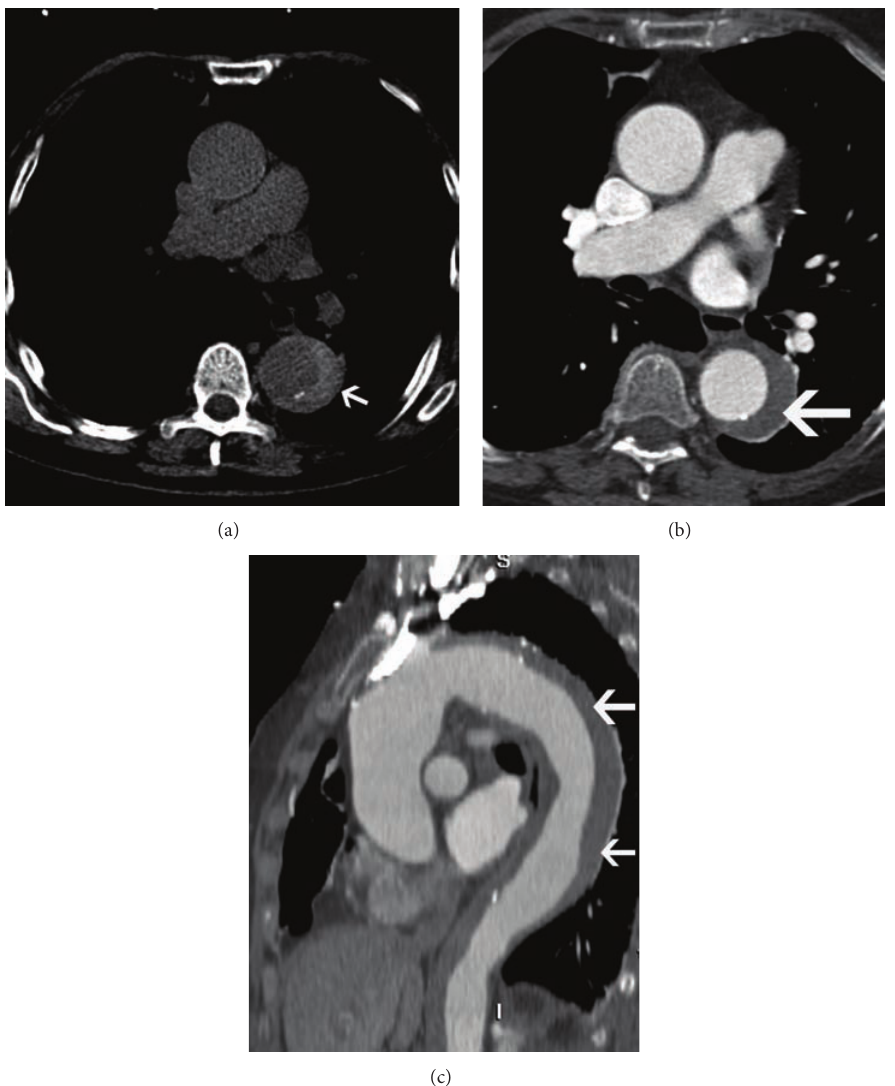
Figure 14: Intramural hematoma—(a) noncontrast axial CT scan of a 67-year-old male with acute chest pain shows a high density collection (arrow) in the periphery of the descending aorta, which is internally displacing intimal calcification. (b) Axial postcontrast CT scan of the same patient shows the hypodense collection (arrow) in the periphery of the contrast opacified aorta. Although it appear hypodense, the mean attenuation value was 80HU, which is higher than that for a thrombus. Also, the intimal calcification goes against a luminal thrombus. (c) Sagittal postcontrast CT scan shows the craniocaudal extent of the intramural hematoma